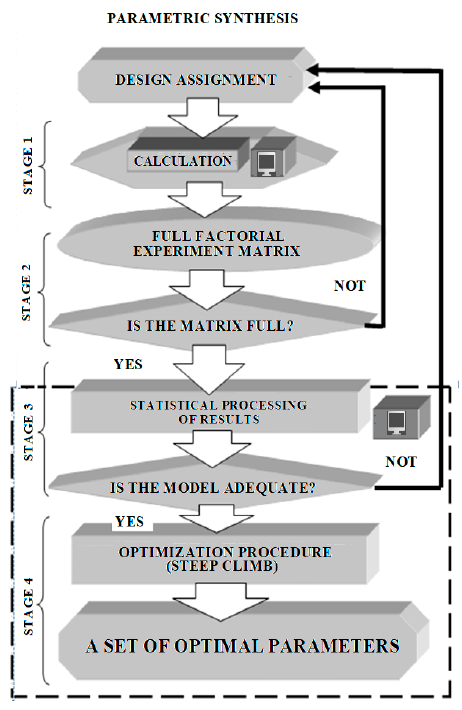
Figure 1. The procedure for complex parametric synthesis of a modular machine.